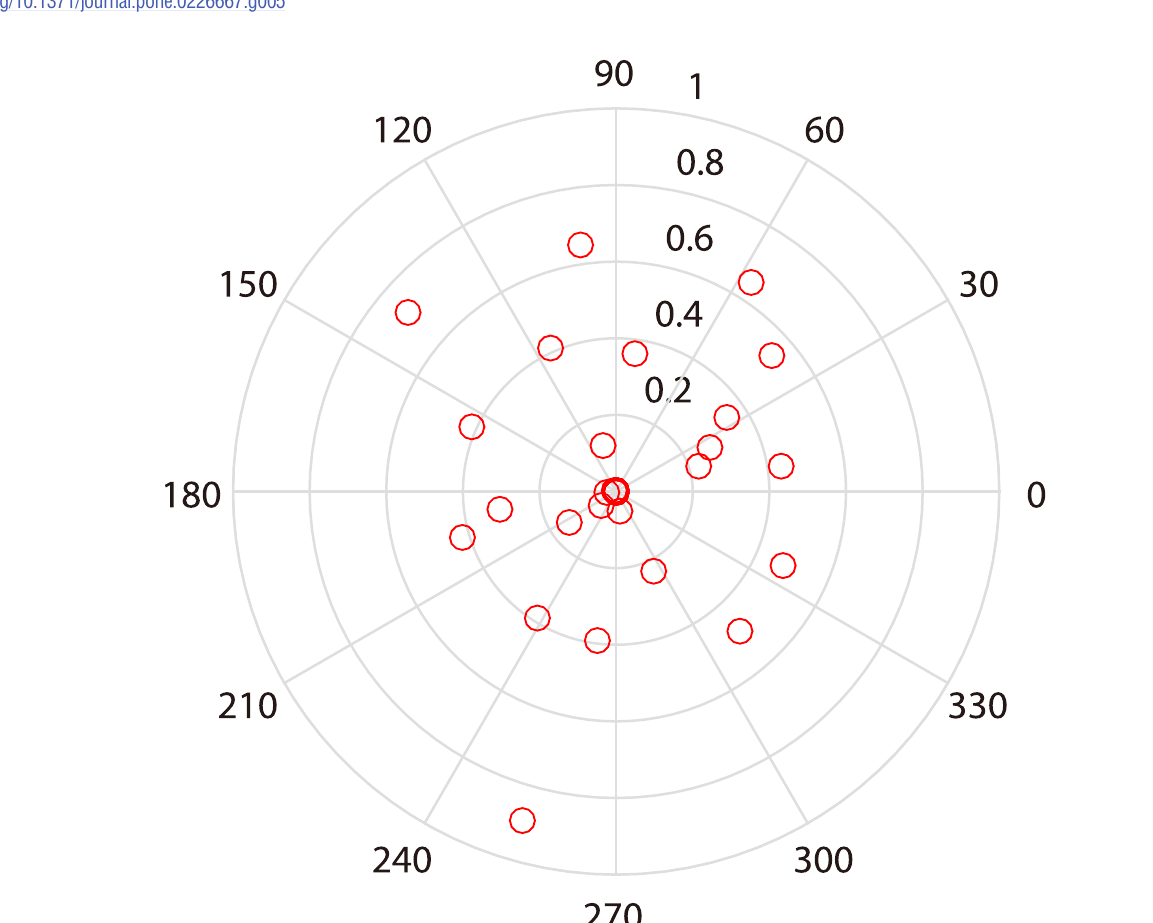
PLOS ONE | https://doi.org/10.1371/journal.pone.0226667 January 10,